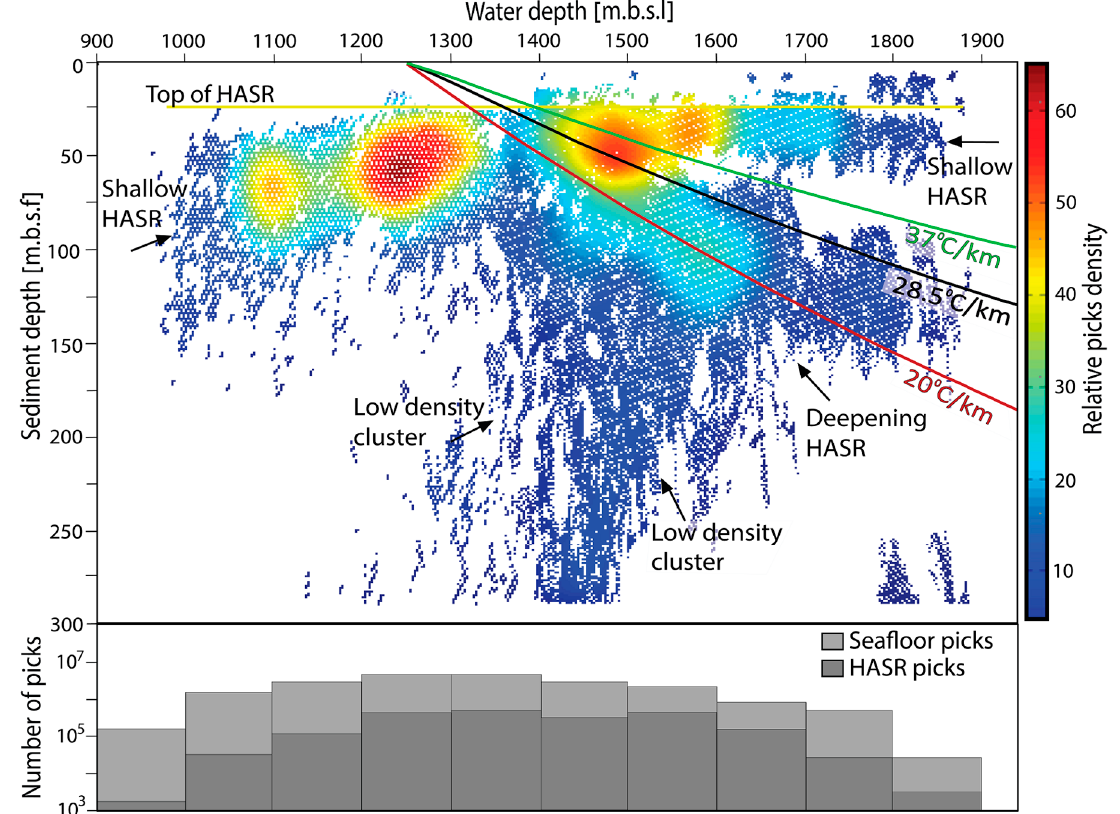
Figure 9. The distribution of automatic HASR picks with respect to the seafloor water depth and the sediments depth below the seafloor. The color scale (right) represents the relative density of picks, i.e., the number of picks found in every 1 × 1 m bins. Overlain curves are the base GHSZ models for geothermal gradients of 20 °C/km (red), 28.5 °C/km (black), and 37 °C/km (green). The Shallow and Deepening HASR clusters are evident as distinct trends of high picks distributions. The histogram at the bottom shows the total number of positions (traces) in the seismic data (light gray) and the number of automatic HASR picks in 100 m intervals of the seafloor depth. This histogram demonstrates the validity of our picks distribution.